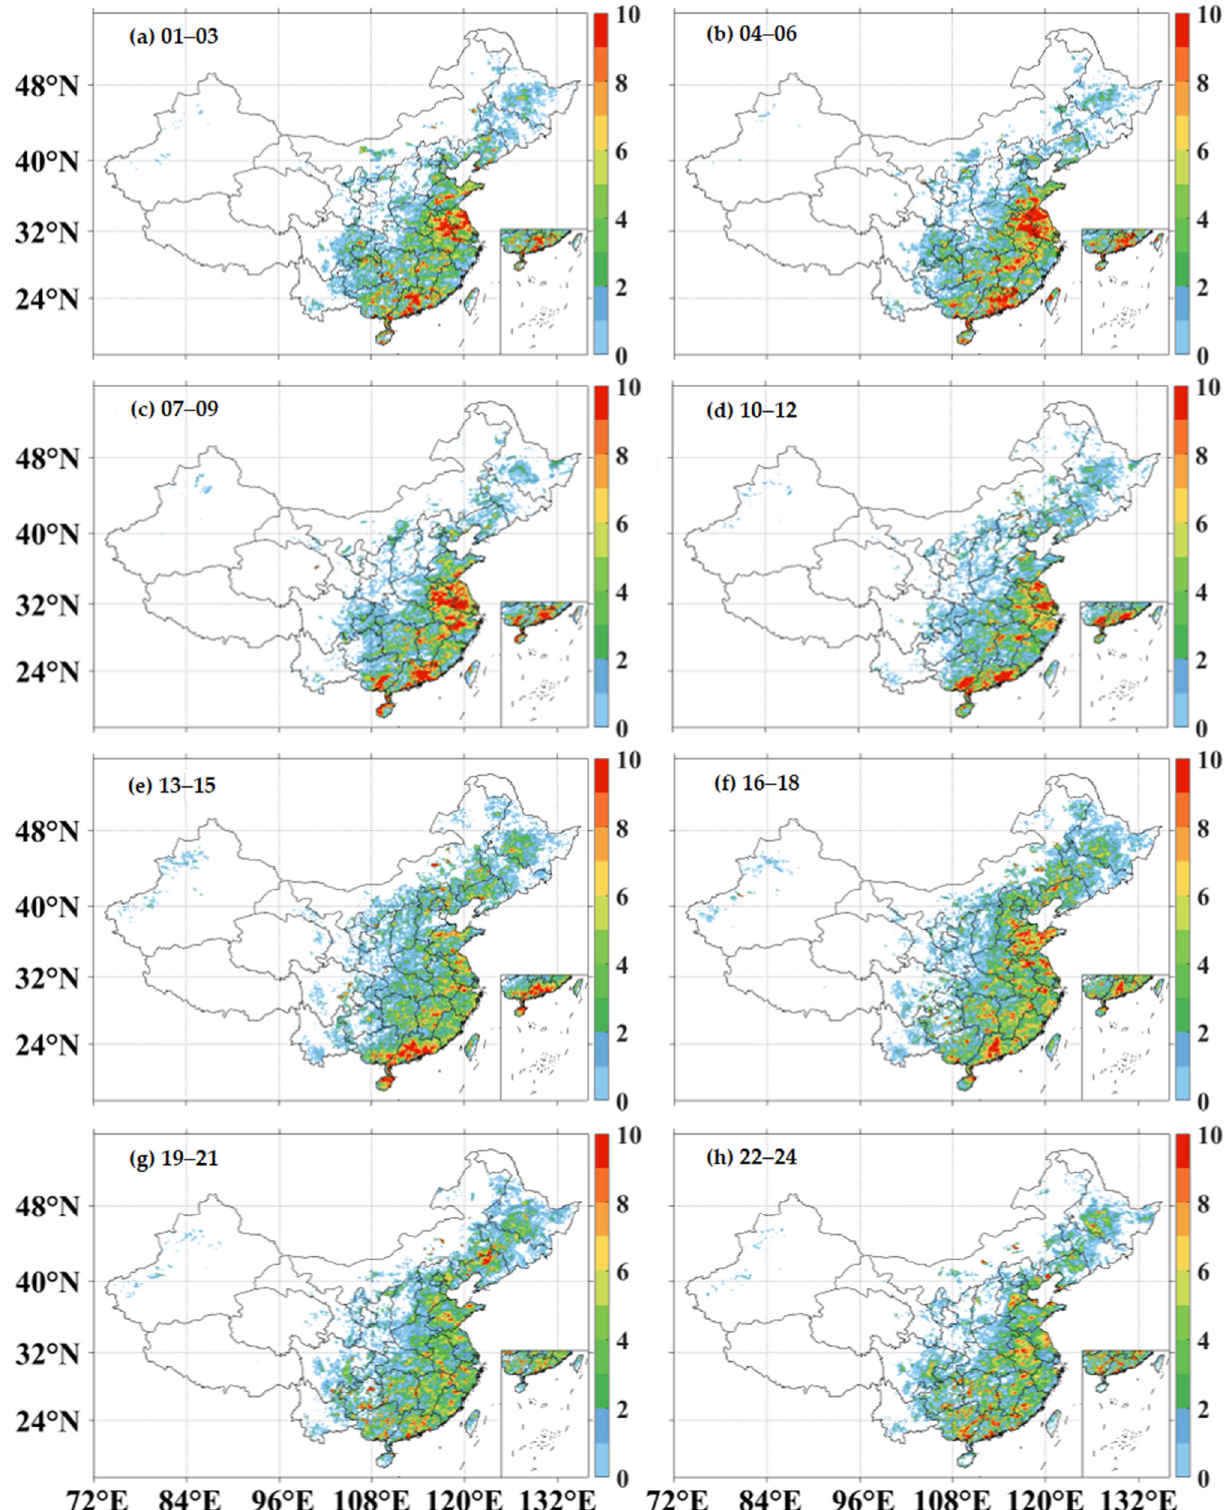
Figure 8. Diurnal variation of frequency (%) distribution of convective precipitation for period